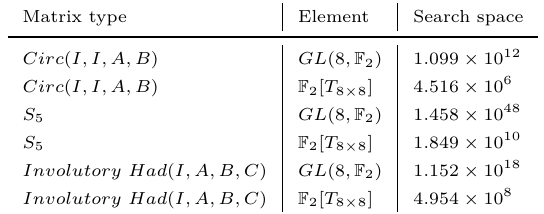
Table 7: Comparisons of search space of constructing lightweight MDS